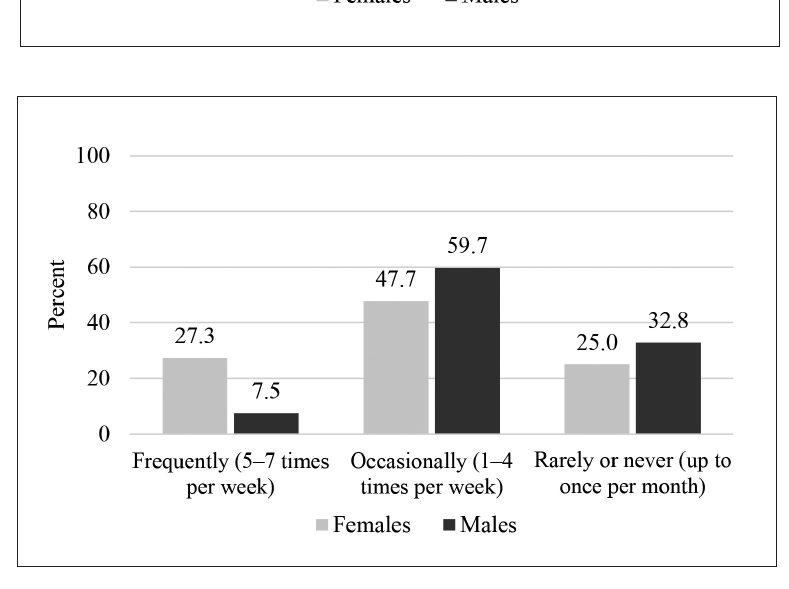
Figure 6. Distribution of smoking in